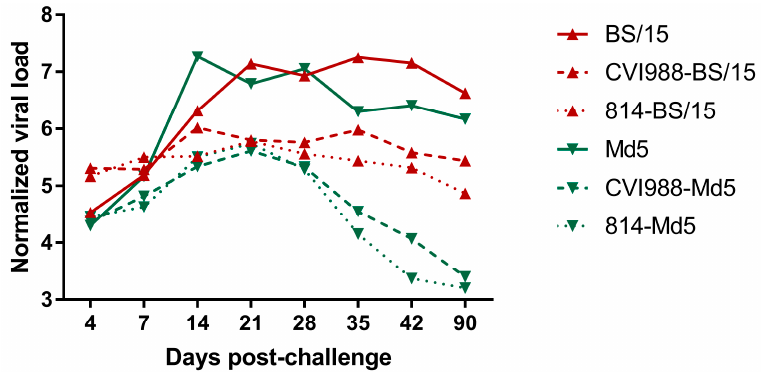
Figure 5. Normalized viral loads in the feather pulps of five birds from the various treatment groups at different time points ( n = 2 in the BS/15 ‐ challenged group, and n = 3 in the Md5 ‐ challenged control group at 90 days post challenge; dpc). Normalized viral loads were calculated as the logarithm of the MDV copy numbers per million cells.